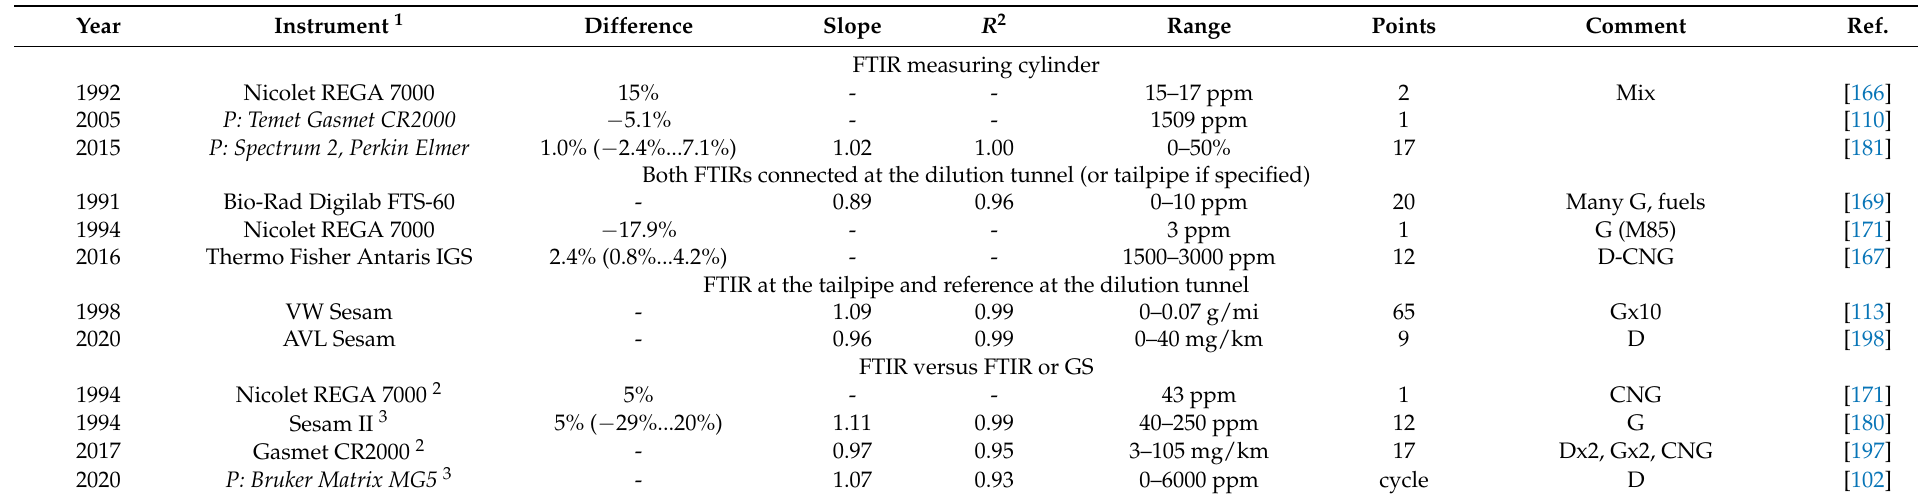
Table A6. Comparisons of FTIR with CH 4 analyzers (FID), unless specified otherwise.